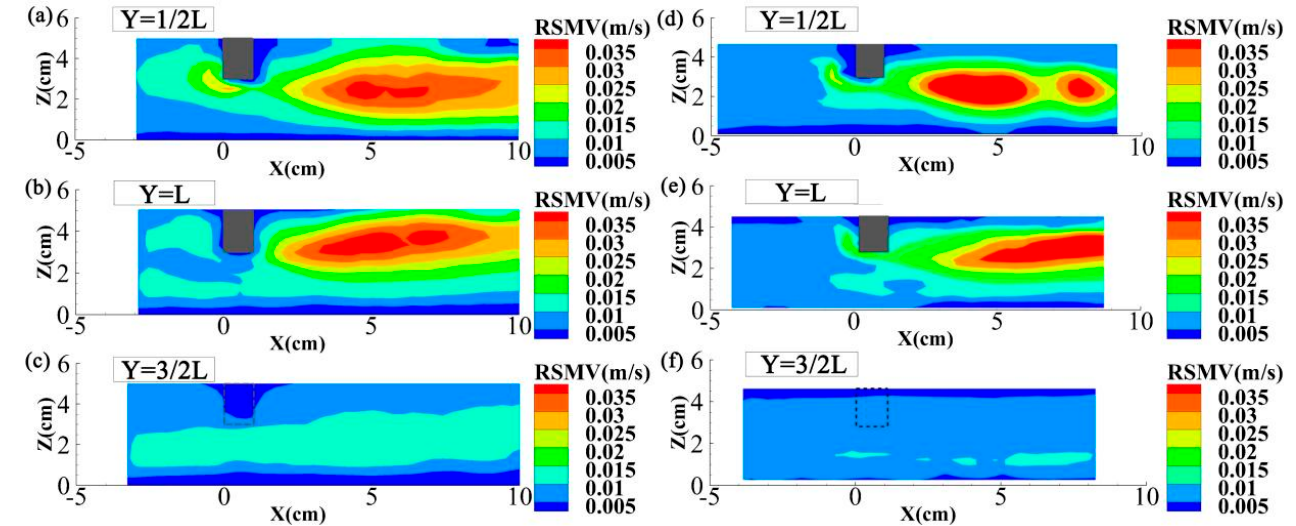
Figure 12. Distributions of vertical turbulent intensity at longitudinal sections ( a ) Y = 1/2 L, ( b ) Y = L, ( c ) Y = 3/2 L in Case 5 (on the left) and at longitudinal sections ( d ) Y = 1/2 L, ( e ) Y = L, ( f ) Y = 3/2 L in Case 6 (on the right). The grey areas in subfigures ( a ), ( b ), ( d ) and ( e ) demonstrate the floating dike, and the dotted lines in subfigures ( c ) and ( f ) indicate the location of floating dike in the coordinate system.